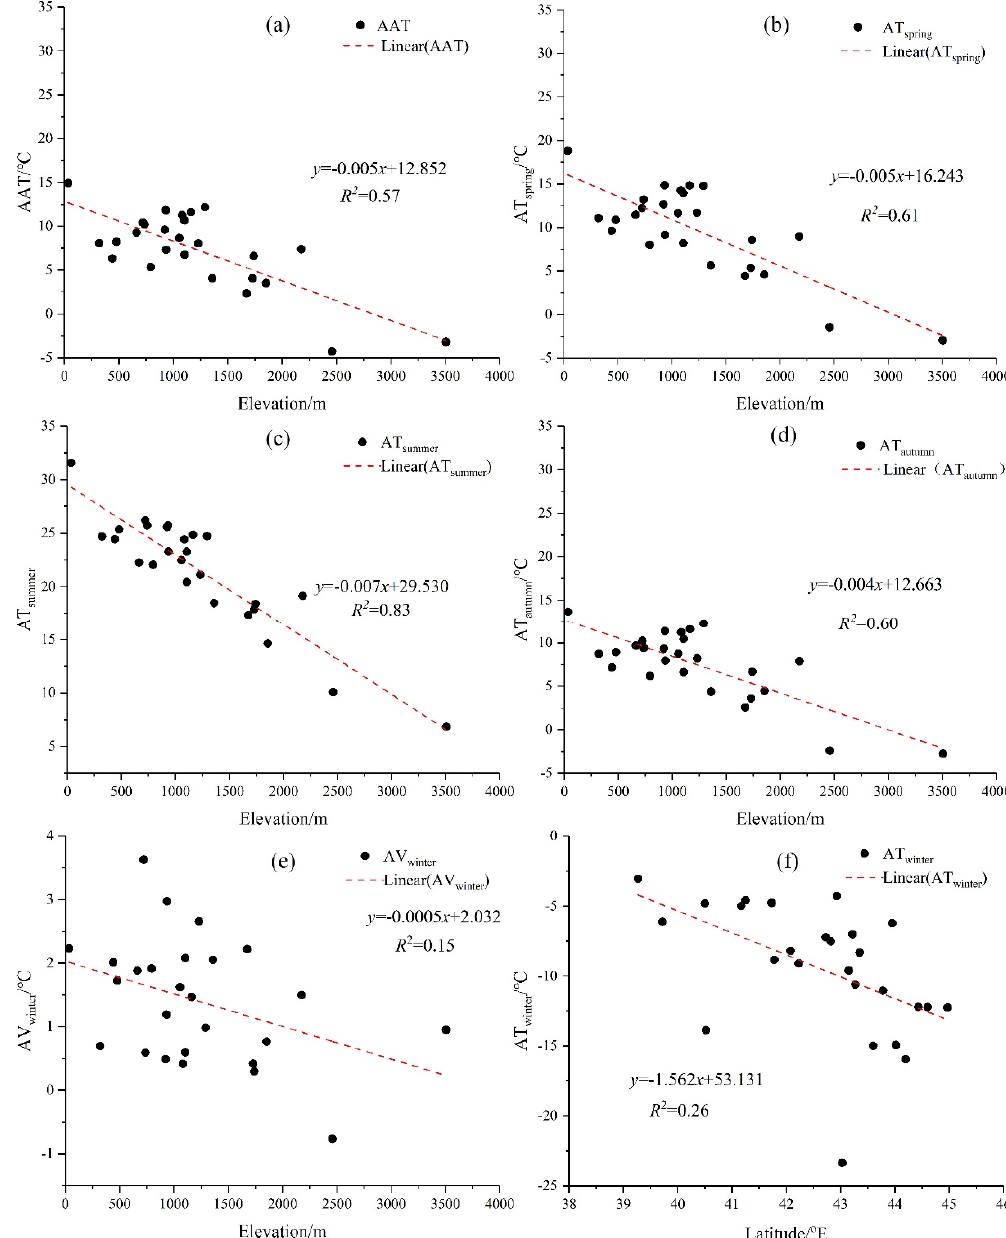
Figure 2. Changing pattern of AAT, AT spring , AT summer , AT autumn , and AV winter at different elevations ( a – d , f ); and AT winter at different latitudes ( e ). However, except for the significant correlation between elevation and AV winter with the negative correlation coefficient of − 0.39 at 0.05 significance level, there were no signifi- cant correlations between elevation and AAV, AV spring , AV summer , and AV autumn . That is to say, no significant elevation dependence existed in annual warming, springtime warm- ing, summertime warming, and autumntime warming within the CTMR. In winter, the amplitude of variation decreased with the increase of elevation. The amplitude of varia- tion of wintertime AT would decrease by 0.05 ◦ C when the elevation increases by 100 m (Table 2 and Figure